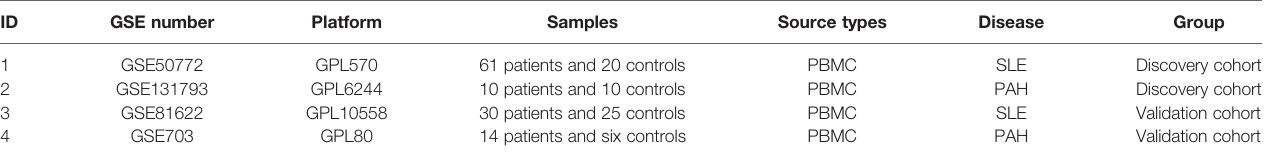
TABLE 1 | Summary of those four GEO datasets involving SLE and PAH